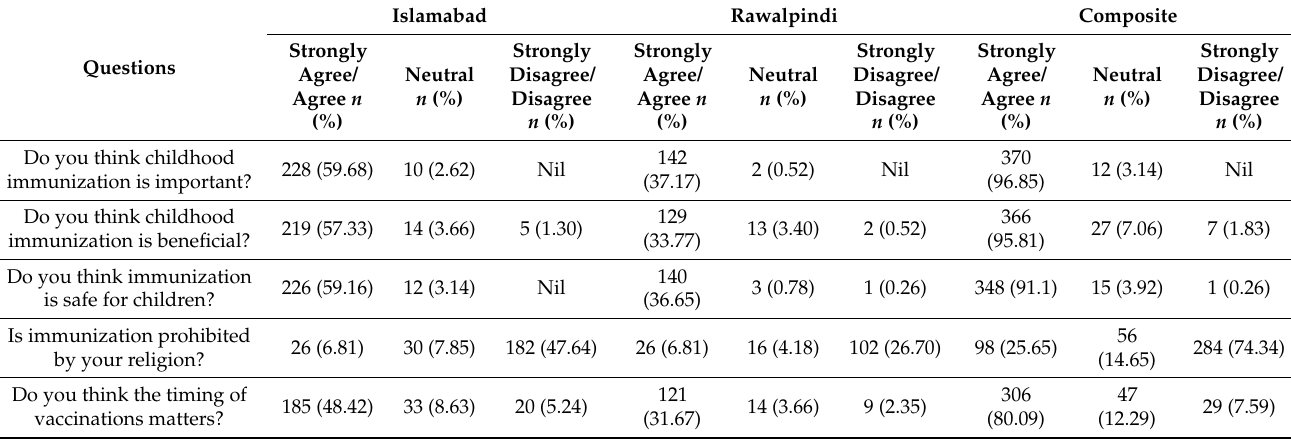
Table 2. Parents’ perceptions about the immunization of their children under two years of